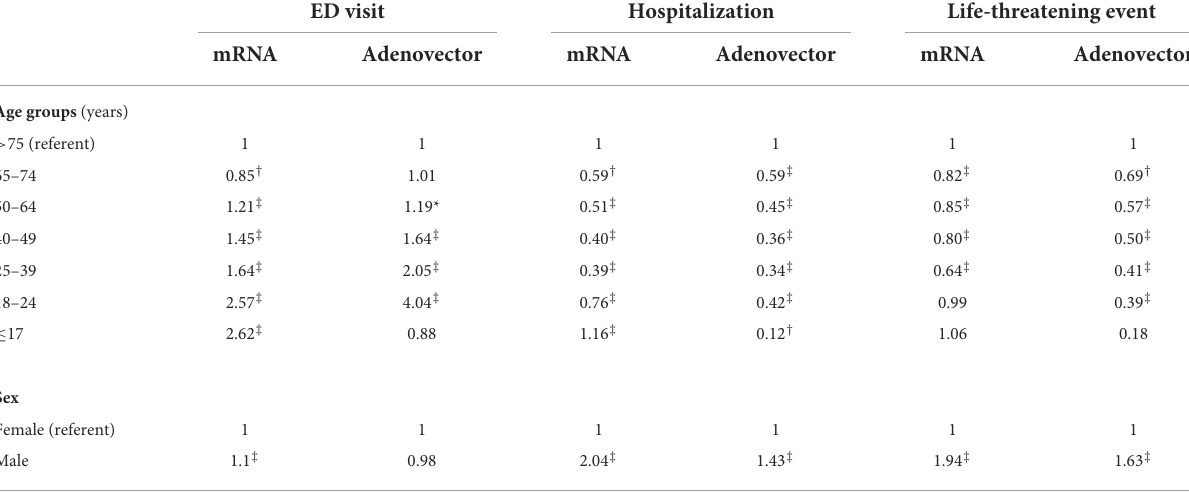
TABLE 4 Interactions for outcomes by demographic characteristics.